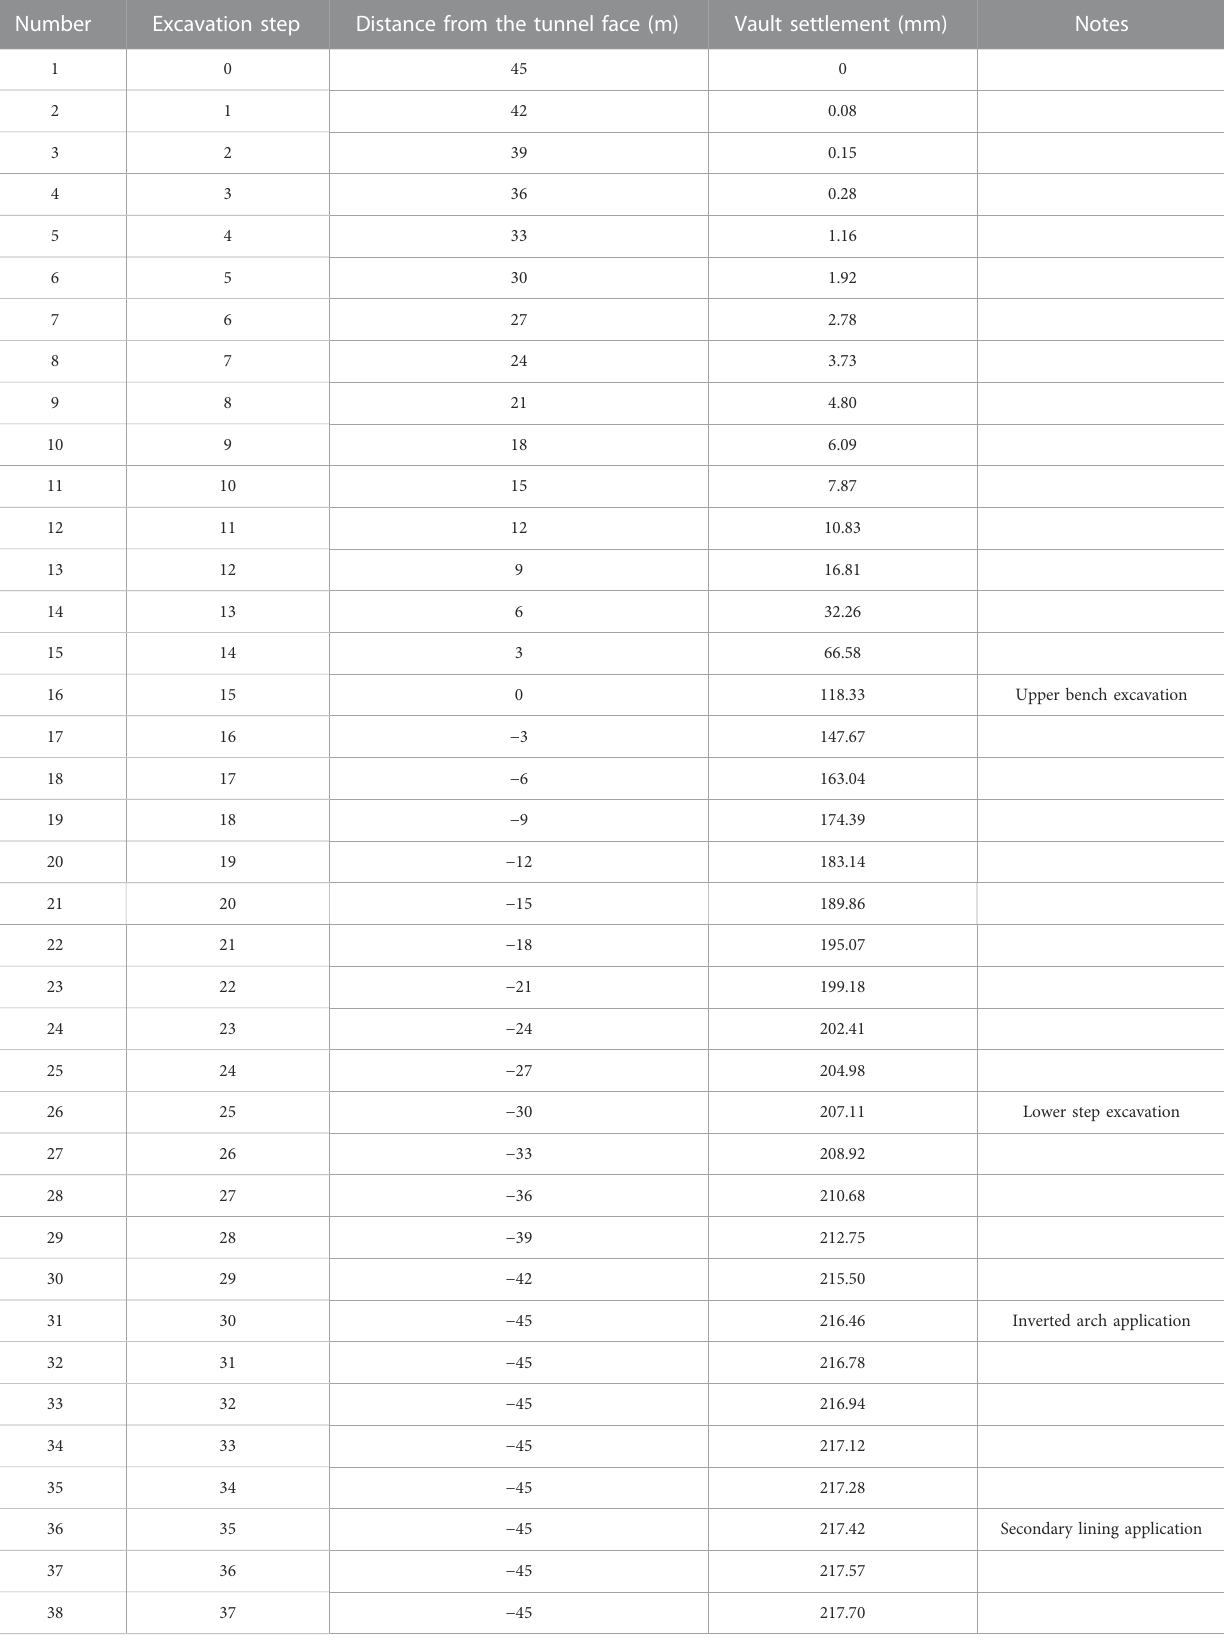
TABLE 3 Calculation results of surrounding rock deformation at different excavation